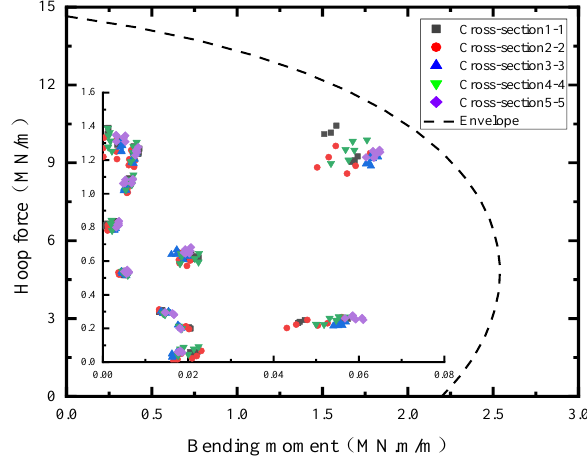
Figure 13. Bending moment and axial forces envelope of each section.